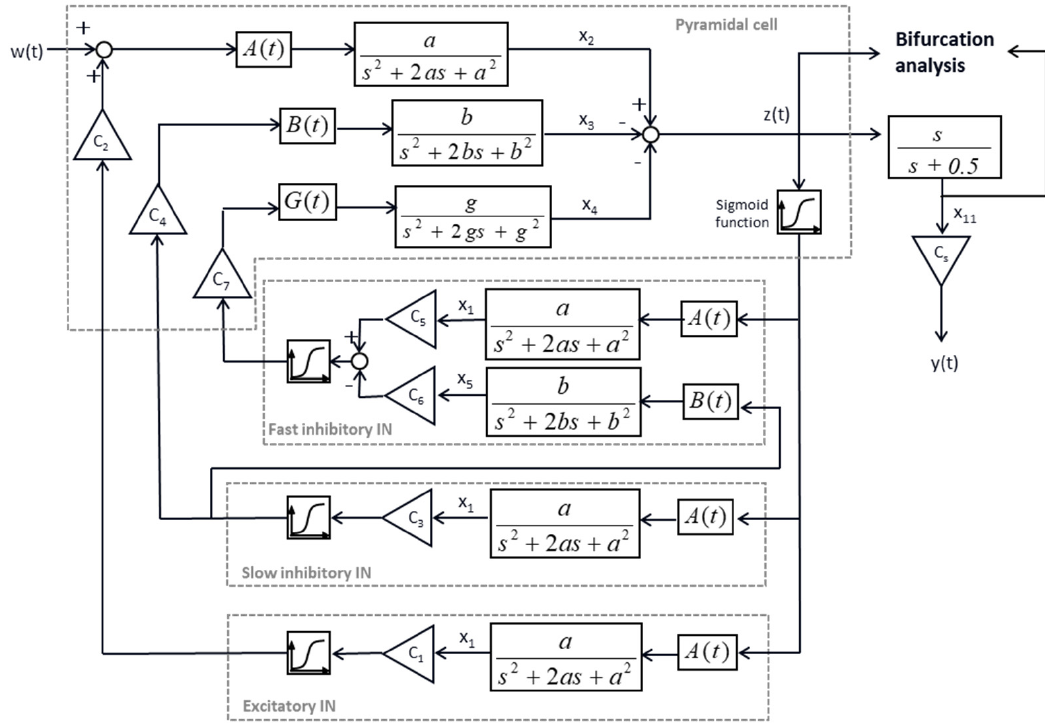
Figure 1. A physiologically based neural mass model of electrical activities of the hippocampus, adapted from [34] .